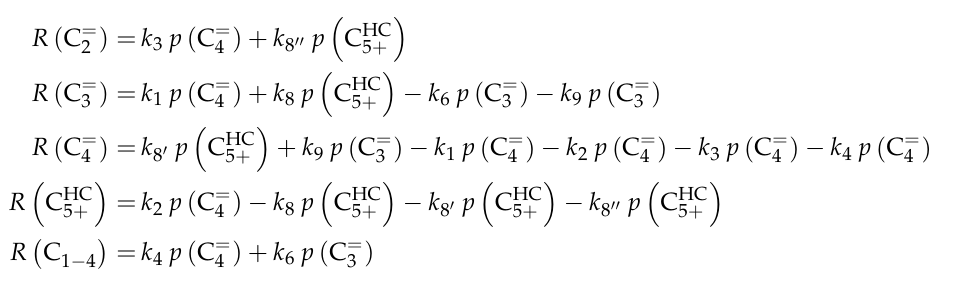
Scheme 5. Net rates of production of the different lumps for the model by Epelde et al. [235] (five lumps). Parameter